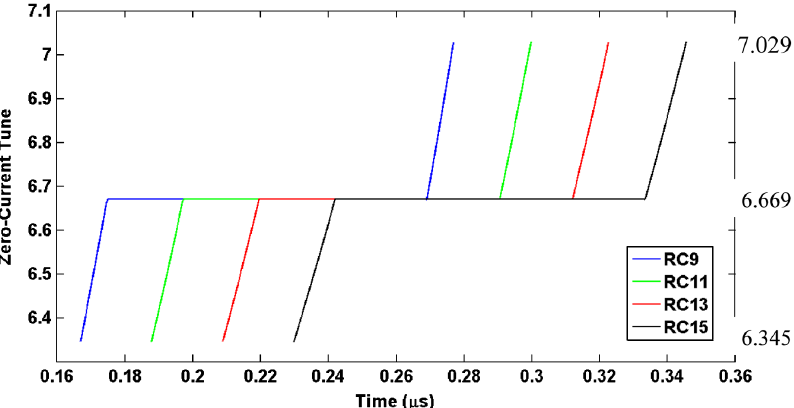
FIG. 4. Analytical zero-current tune profiles calculated on the first turn for the 21 mA beam, at RC9, RC11, RC13, and